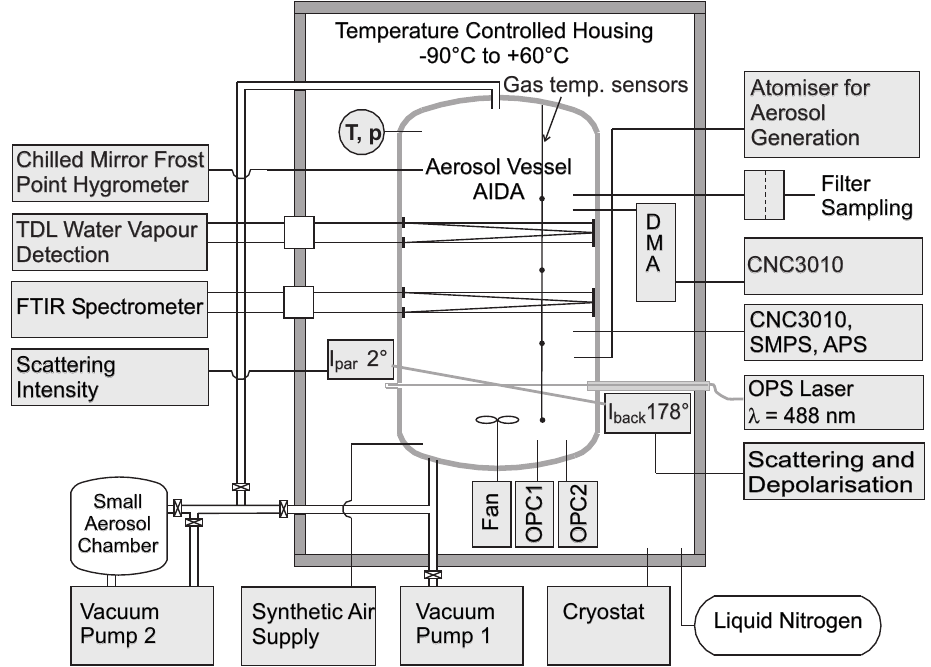
Fig. 2. Scheme of the AIDA aerosol and cloud chamber facility, showing the standard instrumentation for the ice nucleation experiments.